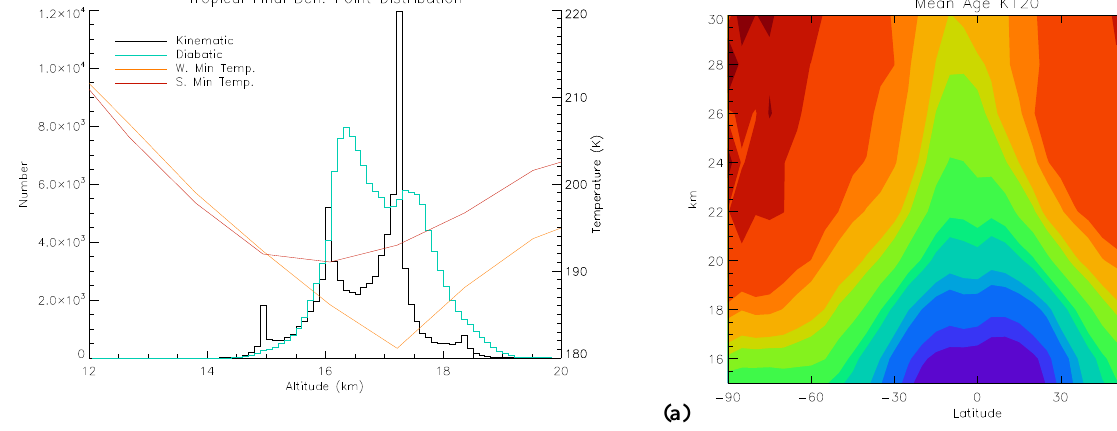
Fig. 2. Final dehydration location distribution vs. altitude for parcels that dehydrated ± 10 ◦ from the equator. Overlaid are the tropical winter and summer and minimum temperature profiles (W. Min. Temp., S. Min. Temp.) for the same region from MERRA. The diabatic parcels dehydrate at warmer temperatures than the kine- matic explaining the dry bias of the kinematic simulation.